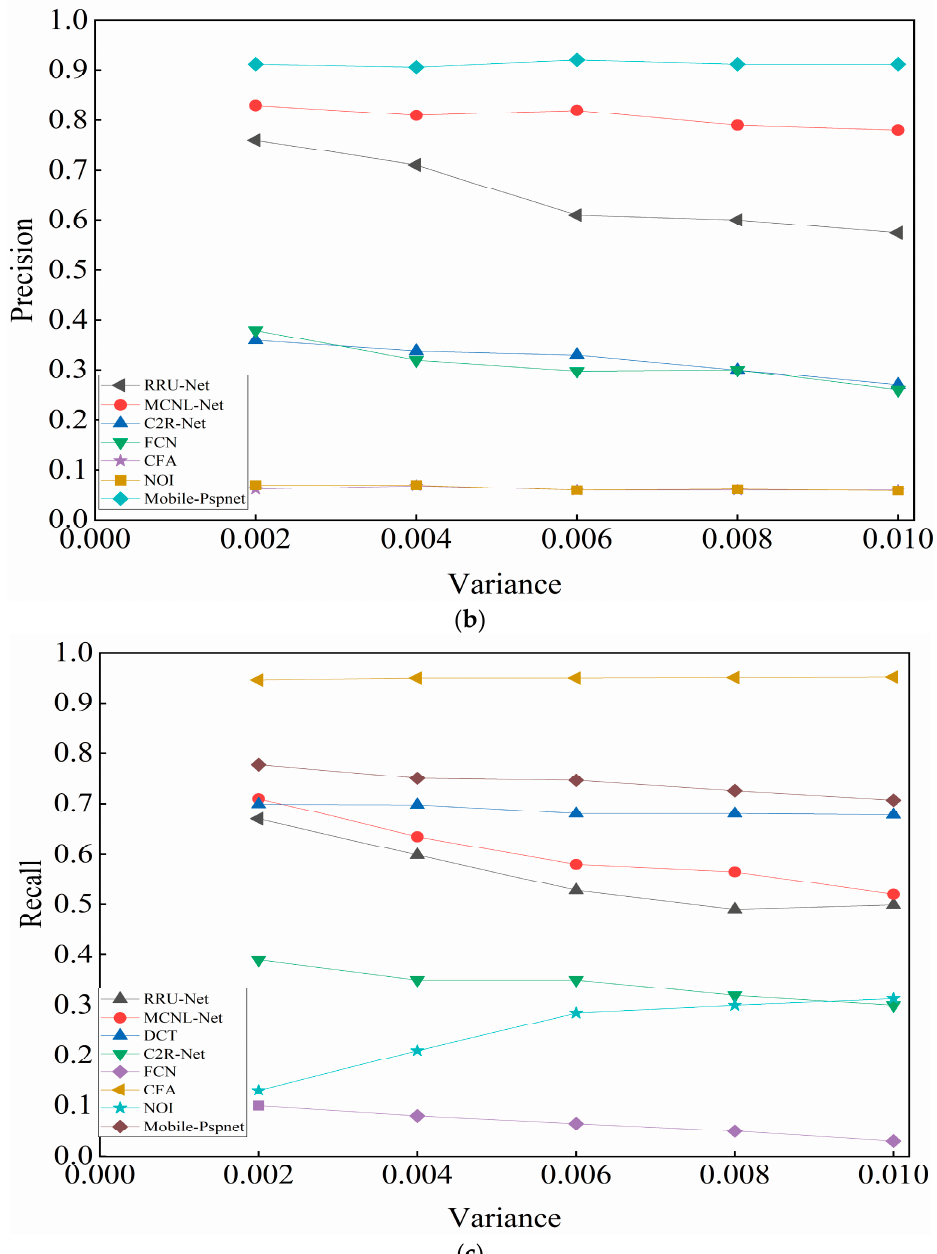
Figure 6. Detection results based on different noise levels of CASIA. ( a ) The influence of different image noise intensity on F-measure; ( b ) The influence of different image noise intensity on Precision; ( c ) The influence of different image noise intensity on Recall.